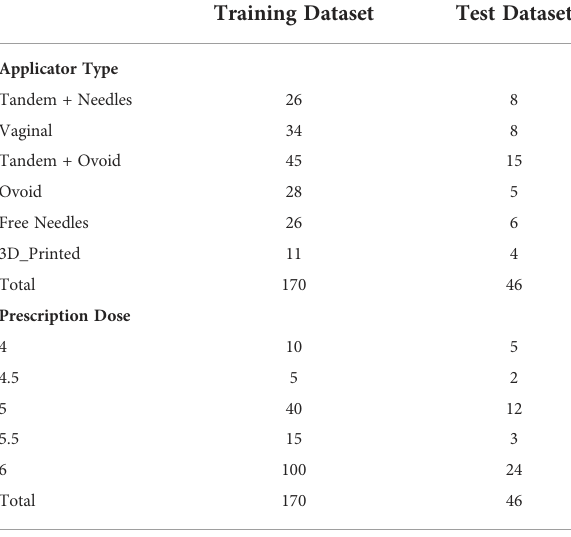
TABLE 1 Treatment characteristics of included patients.